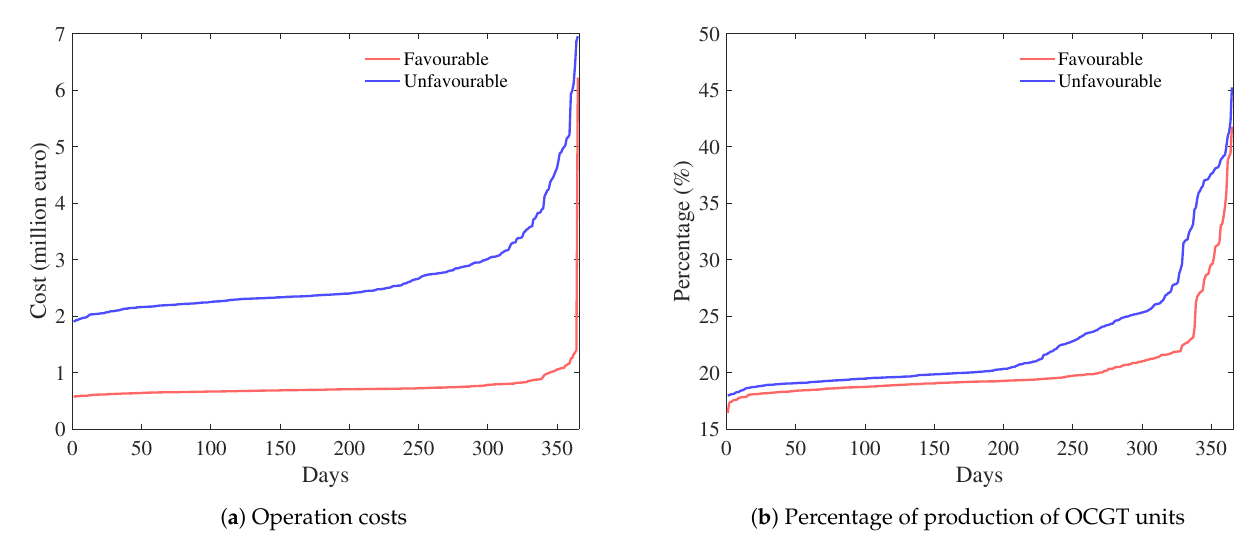
Figure 11. Out-of-sample